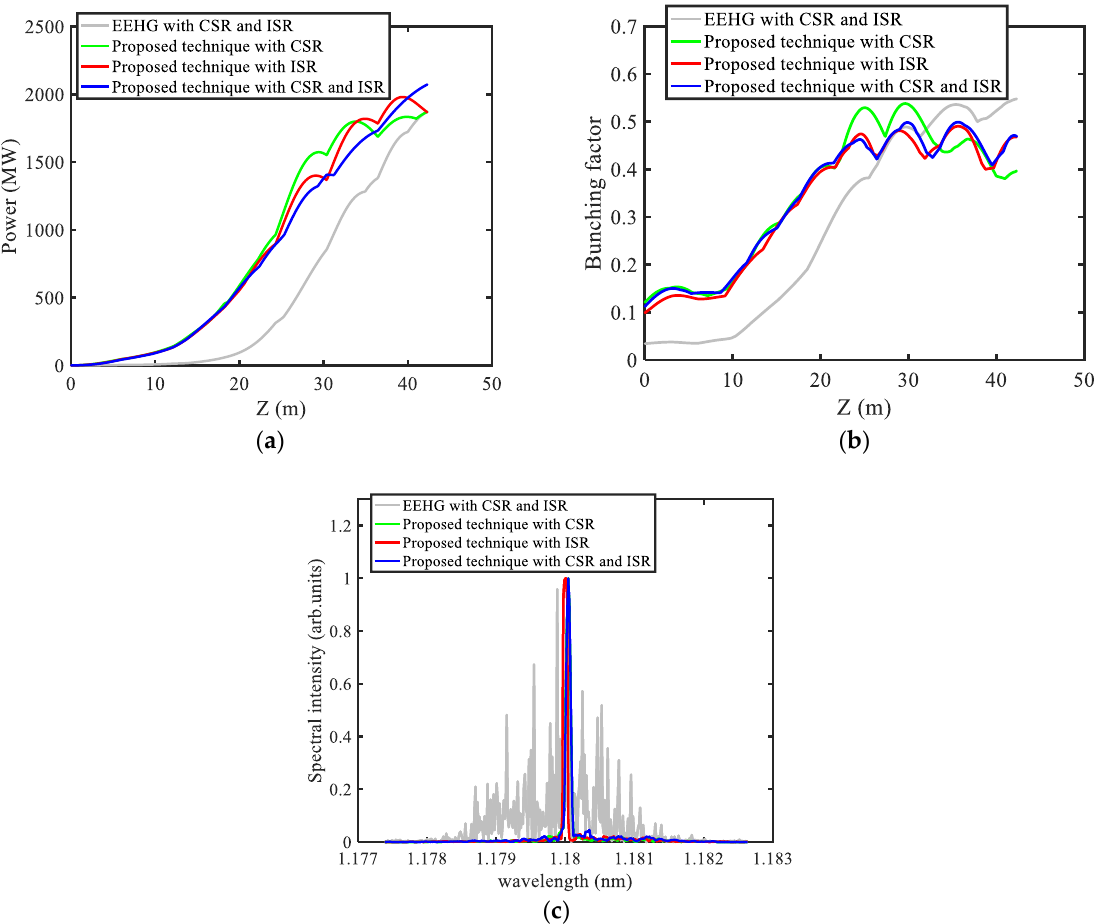
Figure 8. The FEL peak power ( a ) and bunching factor ( b ) evolutions along the undulator for the four cases: the proposed techniques with CSR (green), with ISR (red), with CSR and ISR (blue) and single-stage EEHG (gray); ( c ) The radiation spectra at saturation for these cases.